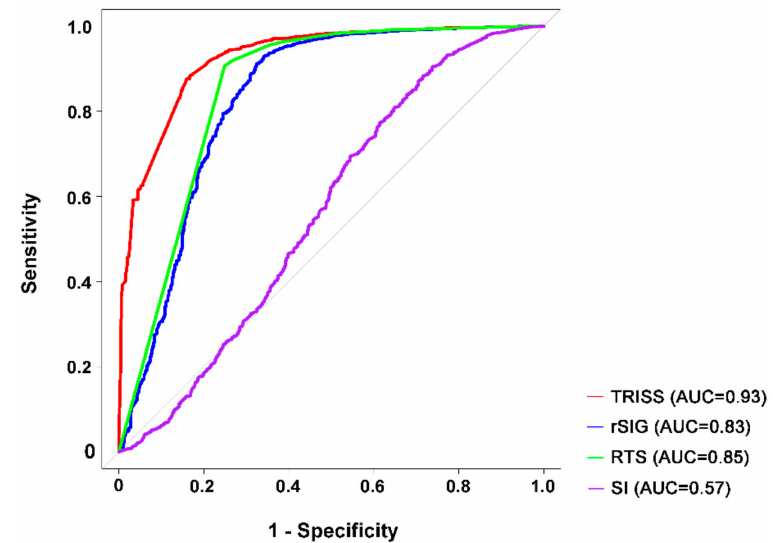
Figure 1. Area under the curve (AUC) of TRISS, rSIG, RTS, and SI in predicting the mortality of patients with all types of trauma.